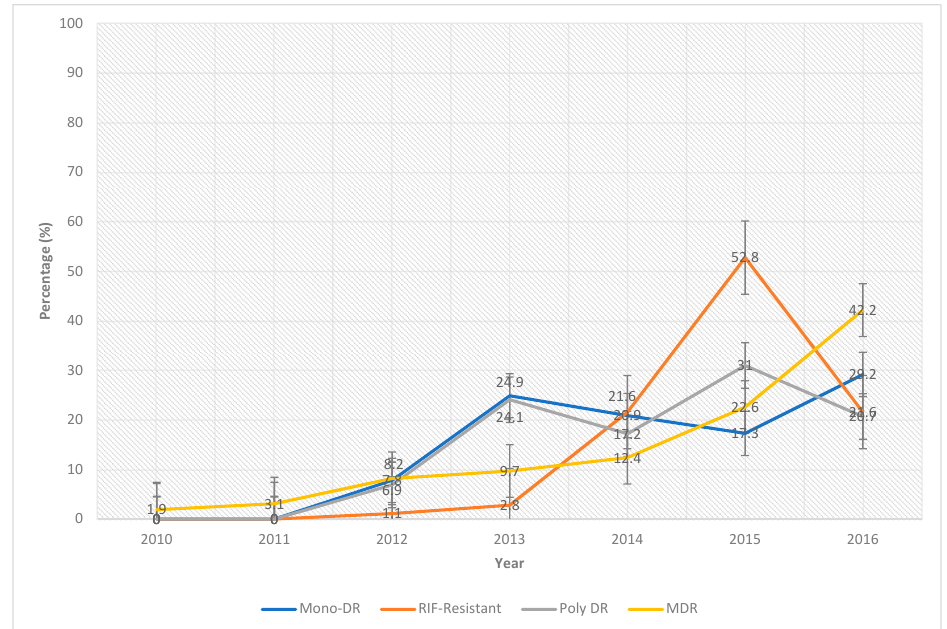
Figure 1. Trend of the pattern of presentation of laboratory-confirmed DR-TB cases by year (2010– 2016).